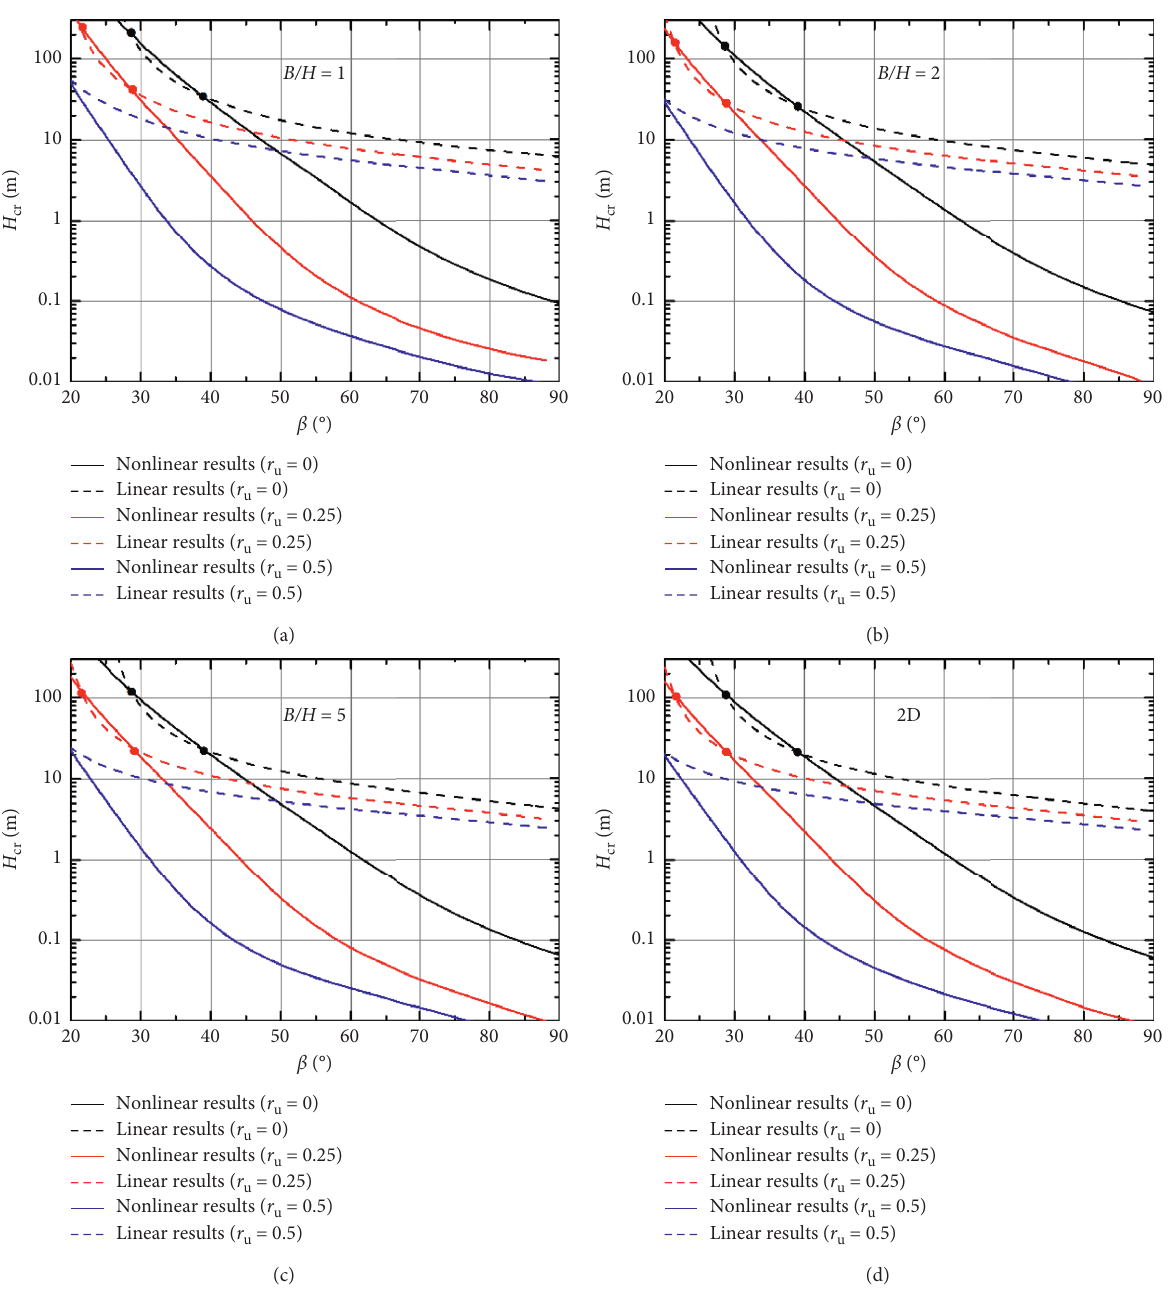
Figure 7: Critical heights of Israeli clay slopes undergoing different pore-water pressures. (a) B/H � 1. (b) B/H � 2. (c) B/H � 5. (d)